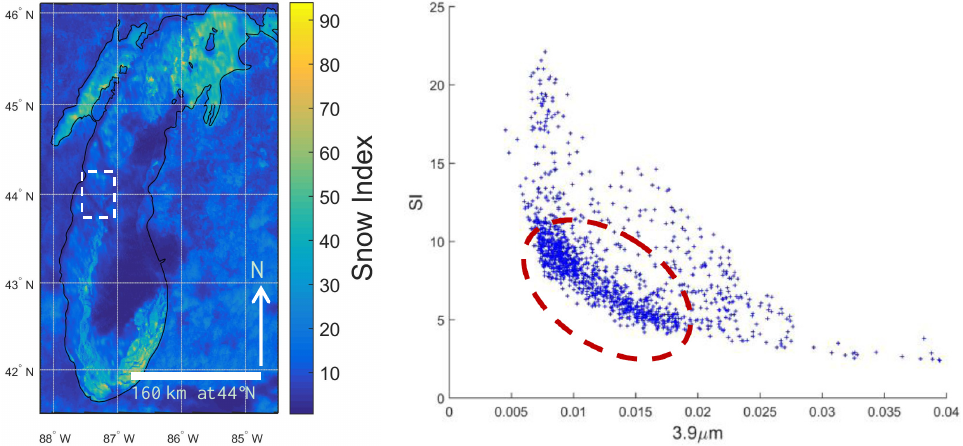
Figure 7. ( Left ) Snow Index (SI) for 1830 UTC on 28 February 2015; ( right ) scatter plot of the snow index to the 3.9 µm. The pixel sampling region (32 × 42) is indicated by the white box in the left figure.